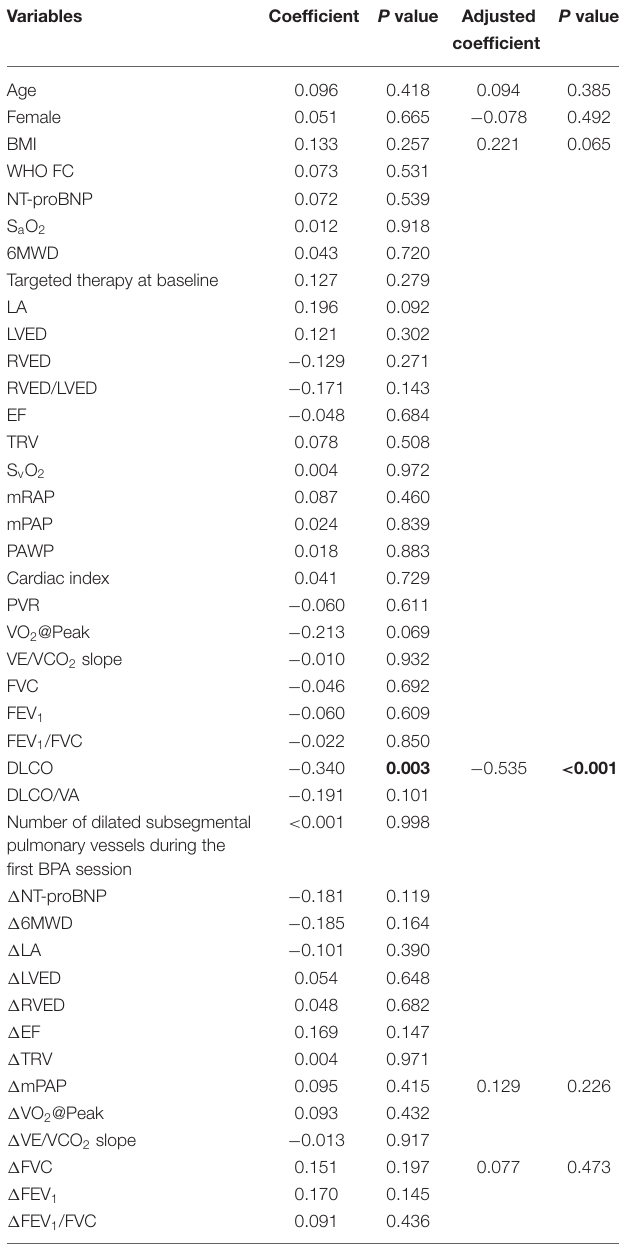
TABLE 3 | Correlation between 1 DLCO and various variables at the baseline or the change of these variables after the first BPA session.